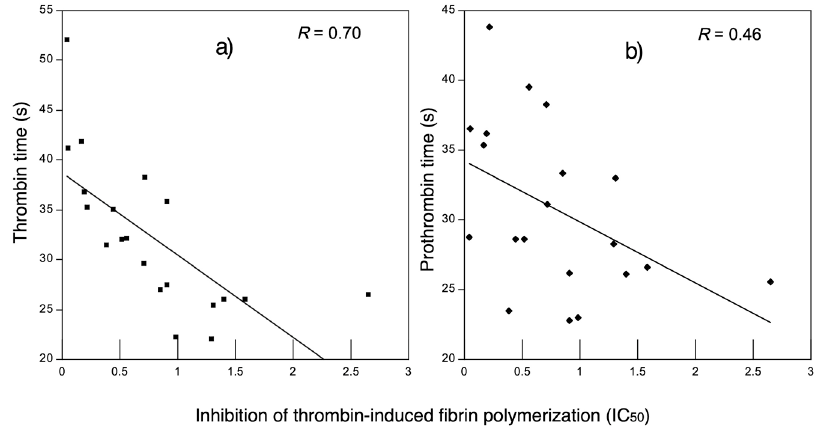
Figure 3. Correlation between thrombin-induced fibrin polymerization (IC 50 ) and anticoagulant activity ( a ) thrombin time and ( b ) prothrombin time of WSF from fermented milk with L. lactis . A significant negative correlation ( p < 0.05) was observed between the thrombin time (s) and thrombin inhibitory activity by WSF.